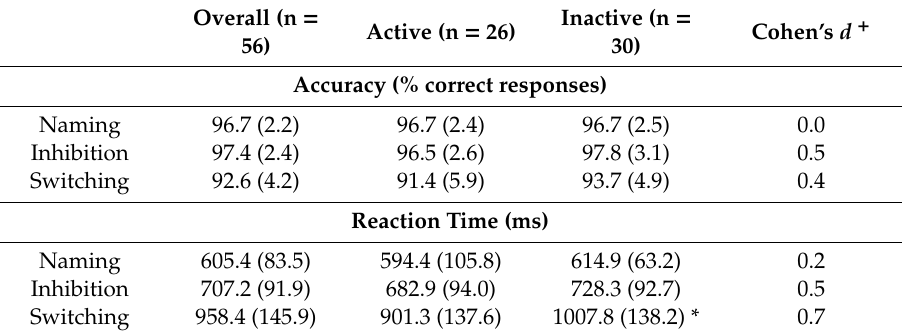
Table 2. Accuracy and reaction time during Stroop tasks. Data are presented as mean